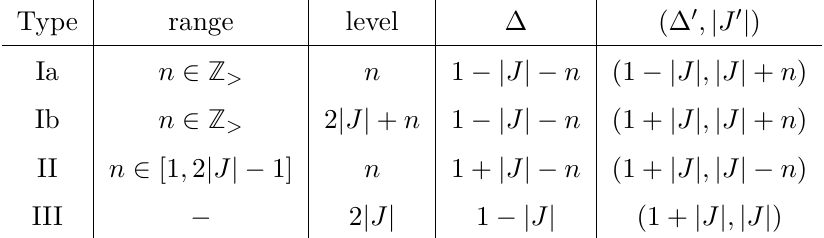
Table 9. Types of primary descendant operators. A spin J primary operator with conformal dimension ∆ has a descendant which is also a primary in four circumstances. The level of the descendant, its dimension ∆ 0 > ∆ and the absolute value of its spin J 0 are presented in the table. Classification of primary